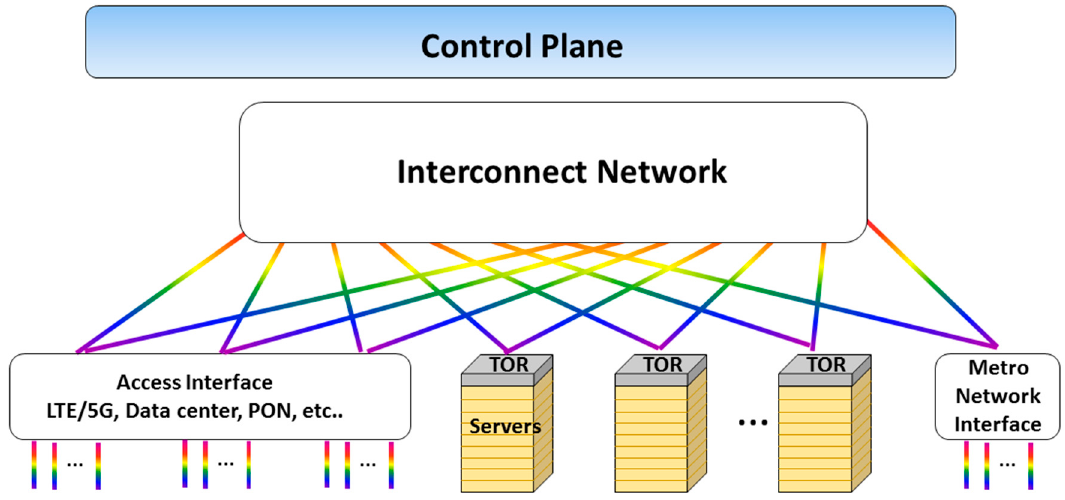
Figure 1. Target hardware built from commodity servers, I/O blades, and switches.